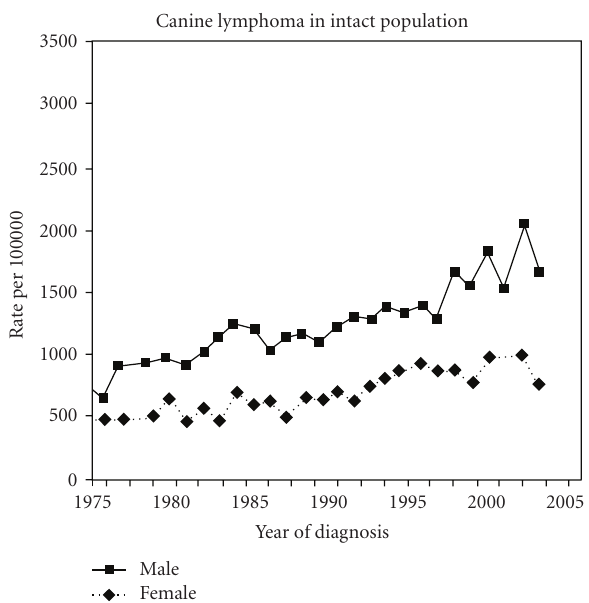
Figure 4: Rate of lymphoma in the canine altered population in the VMDB. Dashed line represents female spayed (FS) dogs and solid line represents male neutered (MN)